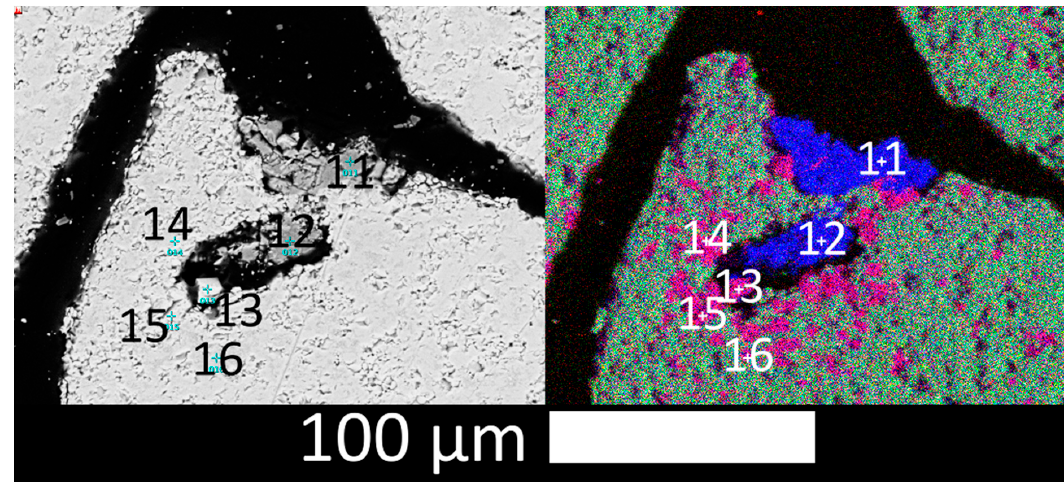
Figure 13. Backscattered electron SEM image ( left ) and Ca–Zr-Ti map ( right ) of zirconolite after 24 h of leaching in sodium carbonate at 70 °C with the locations of EDX analyses. Spectra are shown in Figure 14.